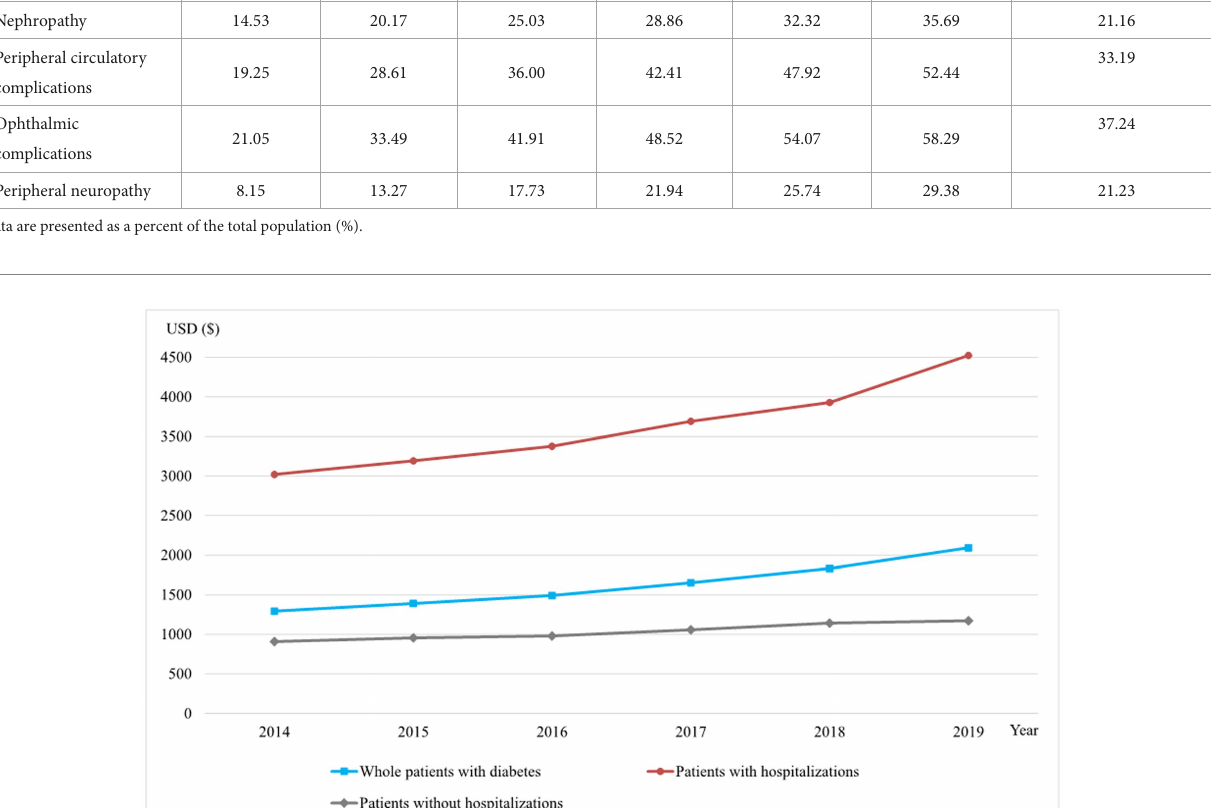
cerebrovascular disease have the highest annual DM cost per patient (3,058.31 USD in 2019), followed by patients with nephropathy (3,011.55 USD in 2019), patients with peripheral neuropathy (2,783.01 USD in 2019), and patients with cardiovascular diseases (2,696.34 USD in 2019). The annual DM cost for patients with peripheral circulatory complications was 2,600.03 USD per patient, and for patients with ophthalmic complications was 2,417.52 USD per patient.